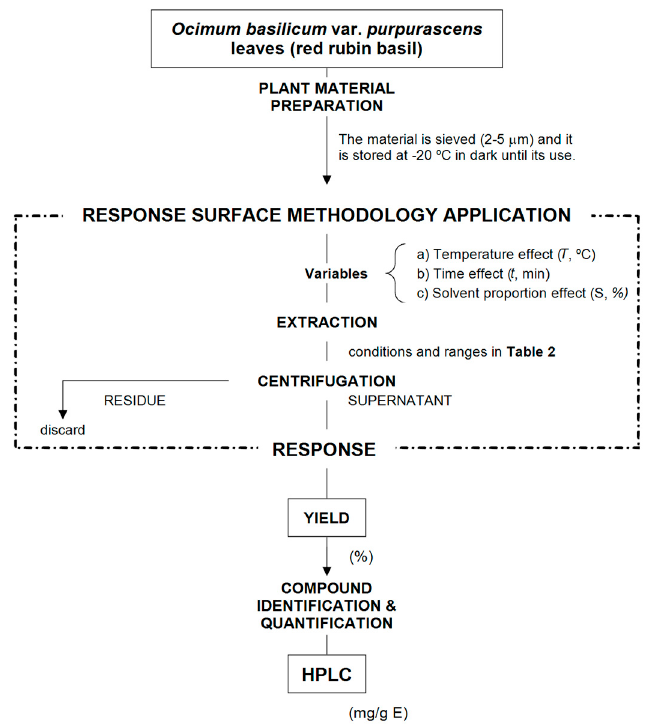
Figure 2. Diagram of the different steps carried out for optimizing the conditions that maximize the extraction responses of the anthocyanin compounds and the total extracted residue (Yield, %).